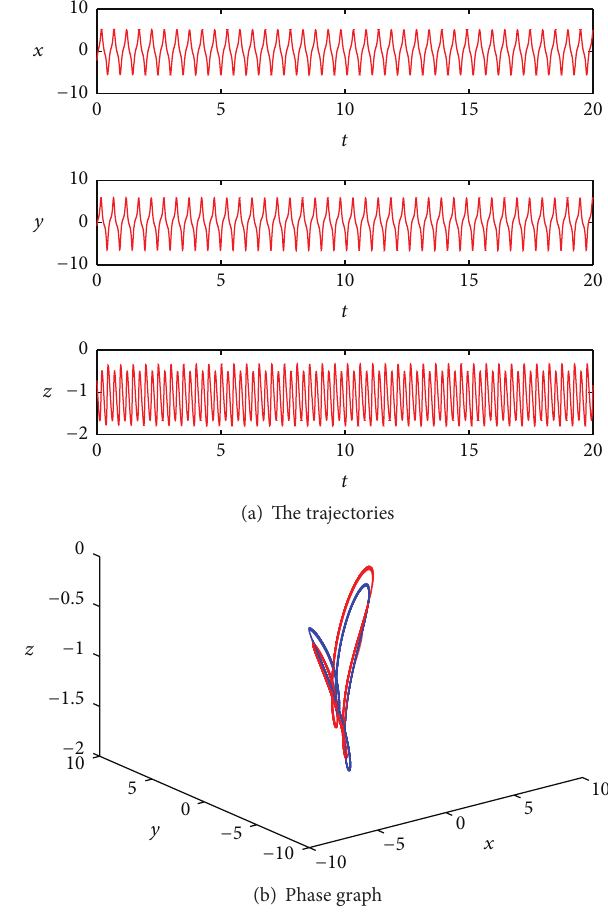
Figure 4: The trajectories and phase graphs of system (2) with 𝜏 = 0.02 < 0.0397 , 𝑘 = −25 at initial values of phase graphs: (3.1,3.1,−1.1) (𝑟𝑒𝑑) , 𝐸 (−3.1, −3.1,−1.1) (𝑏𝑙𝑢𝑒) 𝐸 1 2